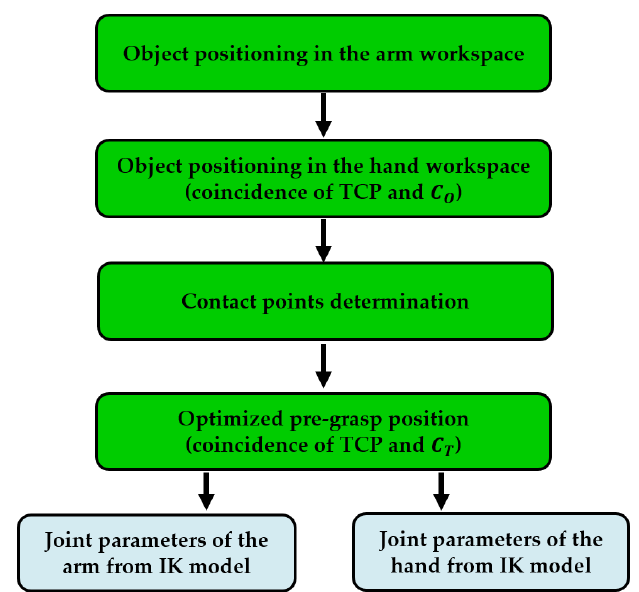
Figure 6. Flowchart for the pregrasp planning strategy of the hand + arm system. IK—Inverse Kinematics.